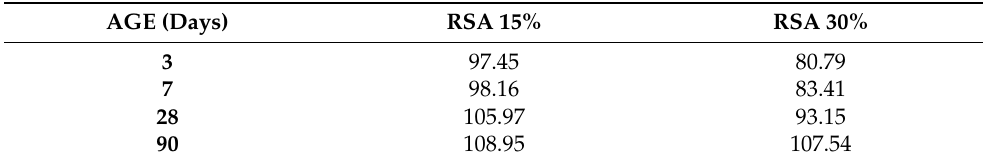
Table 6. Strength activity index of the mortar with RSA.